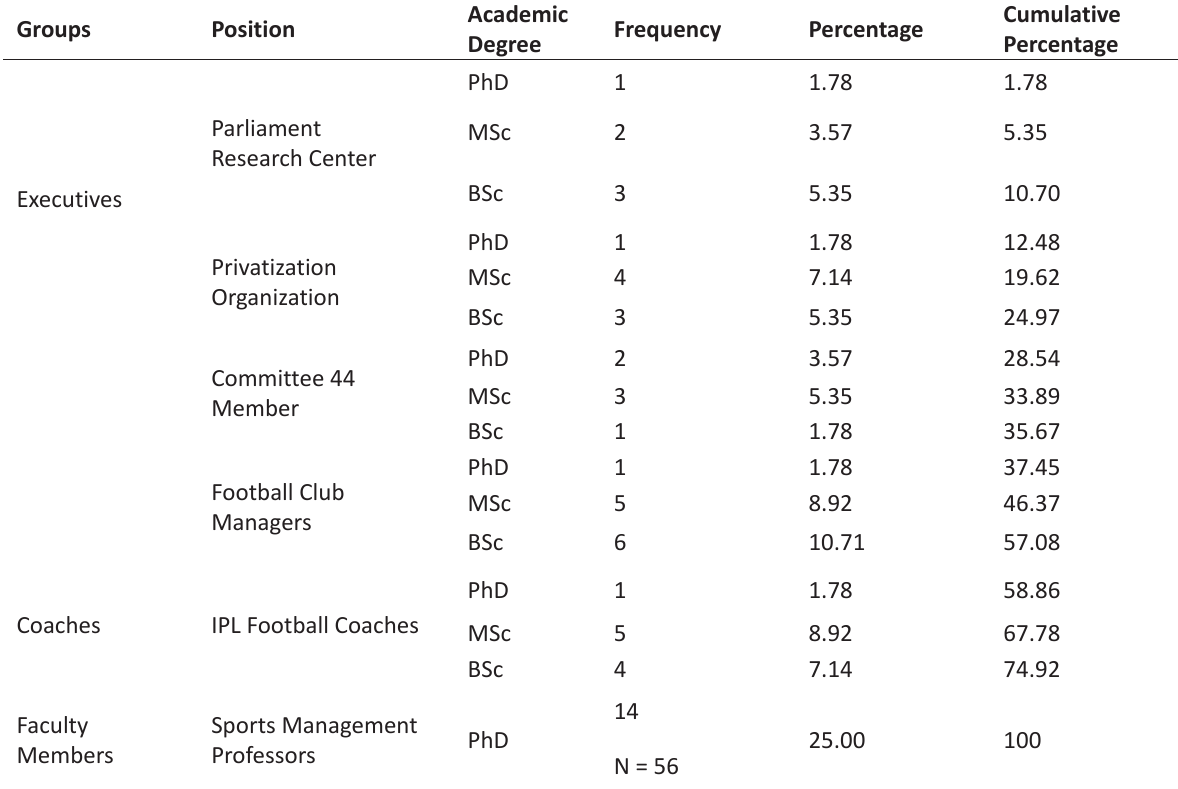
Table 1. Demographics data